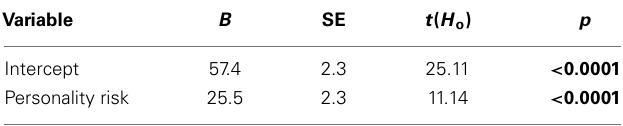
Table 3 | Unstandardized coefficients for the regression analysis with addictive behaviors as the dependent variable and the personality-risk factor score as the independent variable .